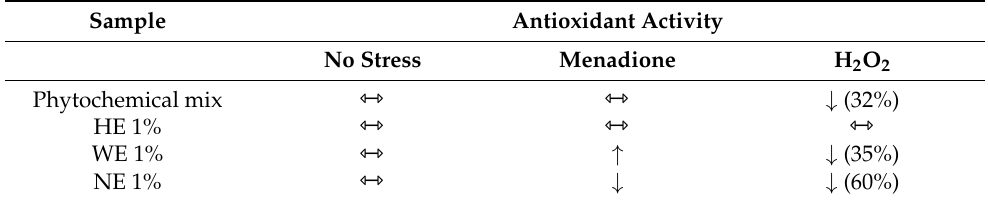
Table 4. Schematic overview of the antioxidant activity of the phytochemical mixture and of the spinach extracts ( ⇿ = no activity; ↑ = increase of oxidative stress; ↓ = reduction of oxidative stress).